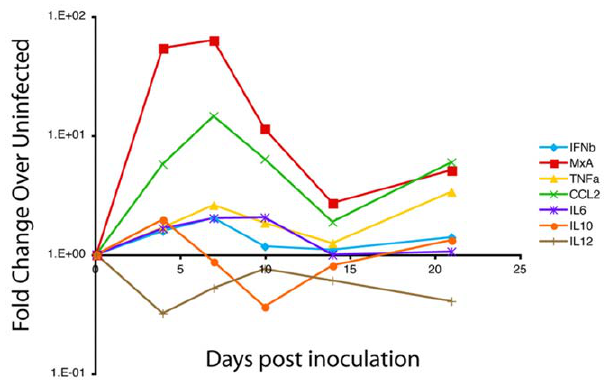
Figure 7. Coordinated expression of innate immune genes and cytokines in brain of SIV-infected macaques during acute infection in brain. A schematic of median values of mRNA levels for all cytokines measured by RT-PCR in brain tissue from uninfected and SIV-infected macaques euthanized at different time points (4, 7, 10, 14 and 21 days p.i.).